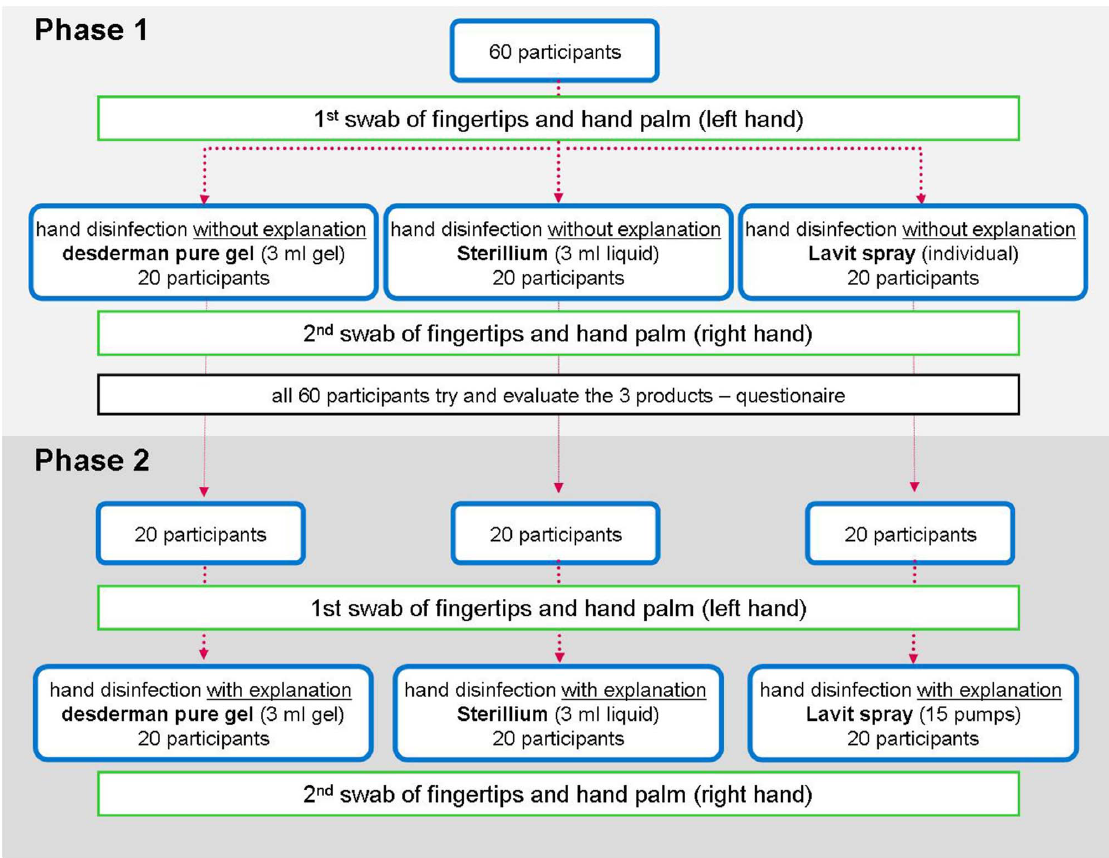
Figure 2. Study design.